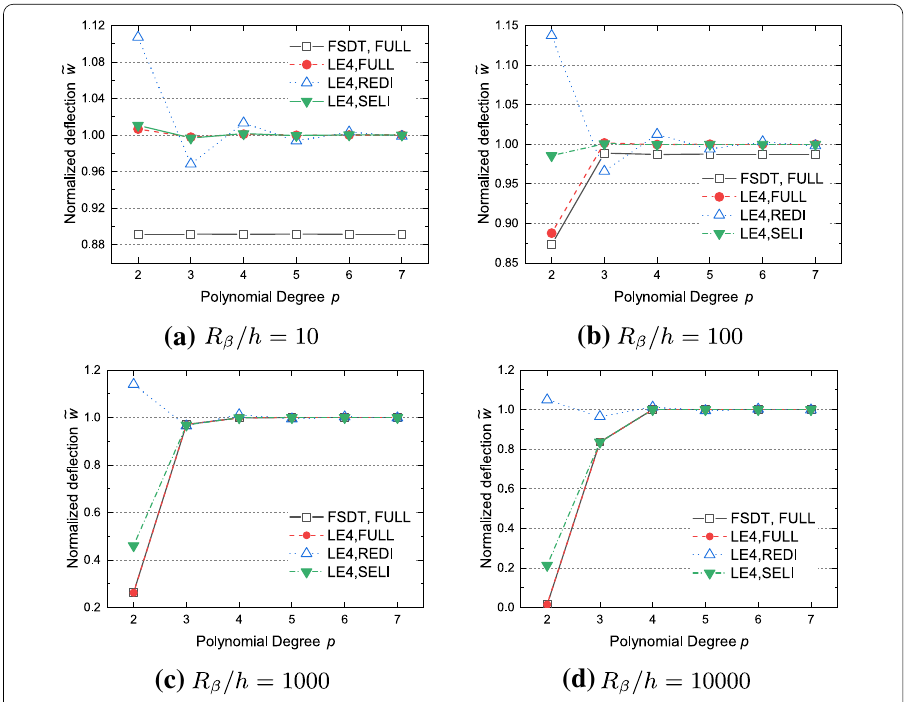
Fig. 13 Convergence regarding the normalized deflection of FE models for the simply supported cylindrical panels under bending, for various radius-to-thickness ratio R β / h